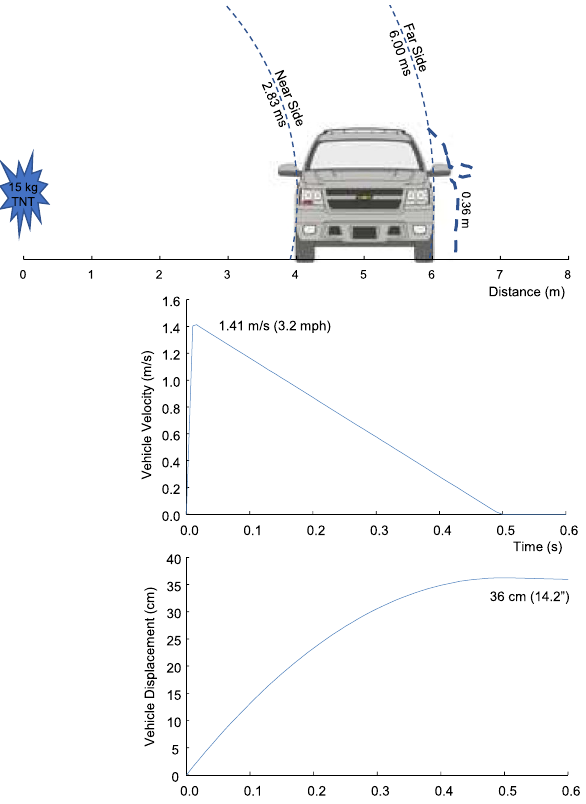
Figure 11. Lateral velocity and displacement of an armored passenger-vehicle with 4 m stand-off from 15 kg Figure 14 shows iso-energy transfer curves for intrusion loading the occupant. The curves relate the velocity (Δv d or v d ) of loading to the deformation (y d ) of the body with equal energy transfer. Each curve is equal energy transfer with the duration ΔT equal to T. For example, the bold line is for E d T/m b = 0.4 (m/s)m. The 0.4 energy curve indicates that high intrusion velocity has similar energy transfer as the 6.7 m/s impact if the displacement is lower. At 20 m/s intrusion velocity, similar energy is transferred at 2.0 cm displacement. The iso-energy curves can be viewed as curves of equal injury risks. The risk increases as the energy transfer increases to a higher iso-energy curve, as shown in Fig. 15. The measurement of intrusion of the occupant com- partment is useful in blast tests and accelerometers are available with 100,000 g dynamic range. The accelerometer is attached to the interior of the vehicle at areas where occupant injury needs evaluation. The transducer measures the local acceleration in a blast test. The acceleration can be integrated for the velocity of intrusion and double